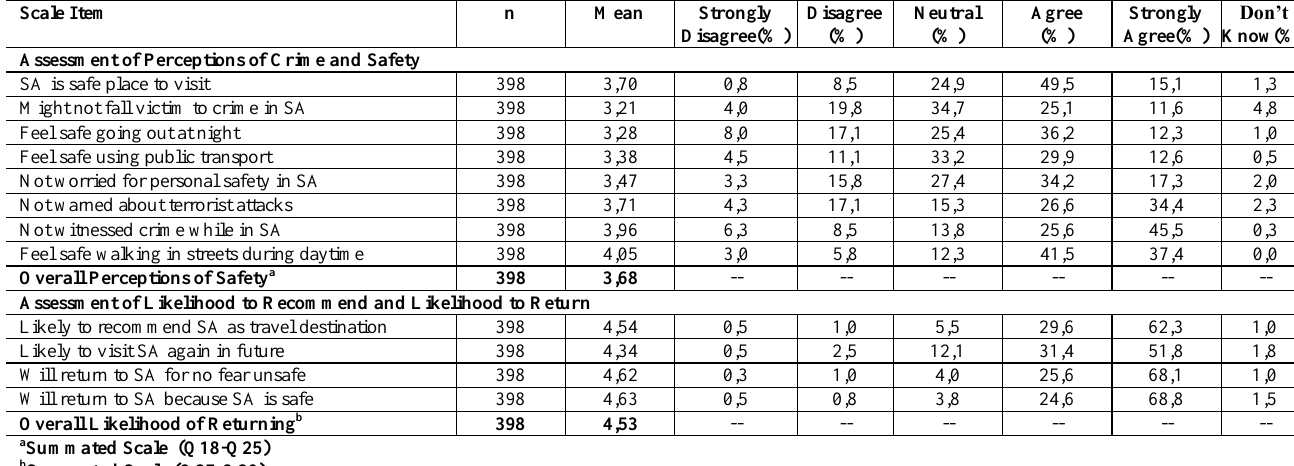
Table 1: Mean scores and frequency of